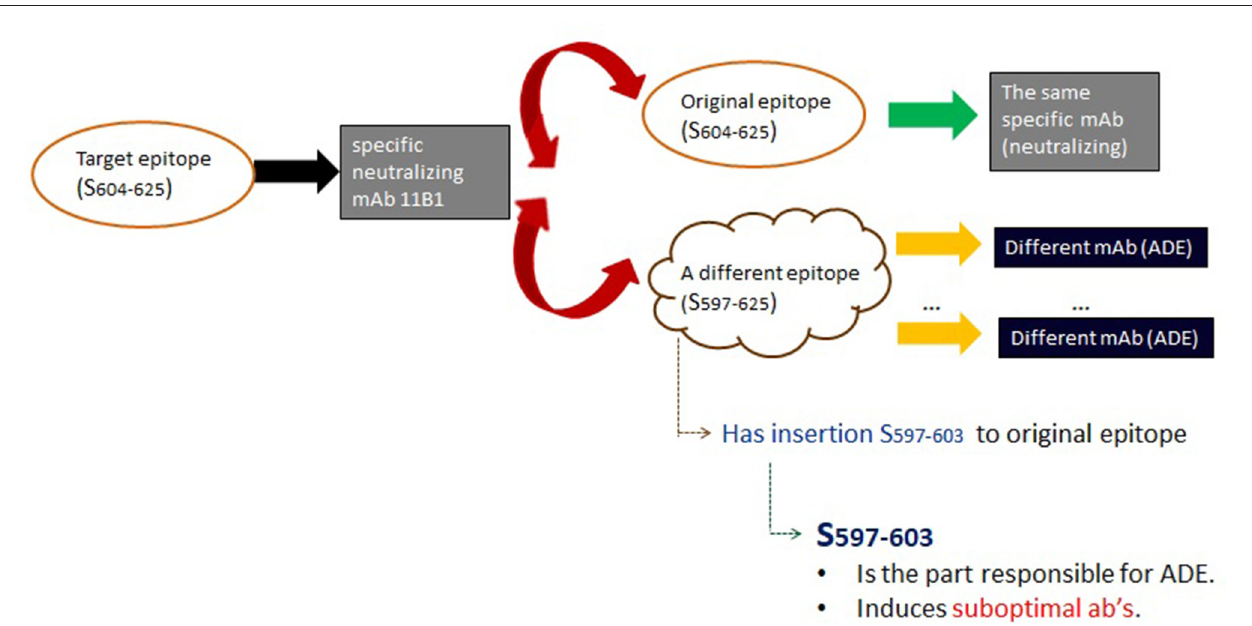
FIGURE 5 | Analysis of the mechanism in Wang et al. (2016) of ADE in SARS-CoV. Wang et al. (2016) demonstrated that an antibody targeting a specific epitope of the SARS-CoV spike protein can enhance virus infection both in vitro and in the experimental monkeys. Significantly, this was linked to a clear epitope sequence-dependent mechanism [see Table 1 in Wang et al. (2016) for nomenclature]. While the targeted epitope induced (black arrow) the anticipated and desired antibodies (gray box), the latter cross-reacted (red arrows) with two epitopes. The first was the original epitope (top), resulting in the expected neutralizing antibodies. However, the second epitope (bottom) led to ADE antibodies (black boxes). The critical feature elucidated by Wang et al. (2016) is that the second epitope (bottom) is merely the original epitope, with an additional N-terminal sequence insert ( S 597 − 603 ). This insert, then, because it is itself immunogenic, was found to be responsible for inducing the enhancing function. However, it only induces sub-optimal antibodies. It is possible that binding of these enables changes in the spike protein, or otherwise catalyzes SARS-CoV attachment to and/or membrane fusion with target cells. The in vitro experiments in Wang et al. (2016) that demonstrate this in Vero E6 cells are particularly striking as the latter lack Fc γ R , and the best understood mechanism for ADE involves Fc -mediated internalization and replication of